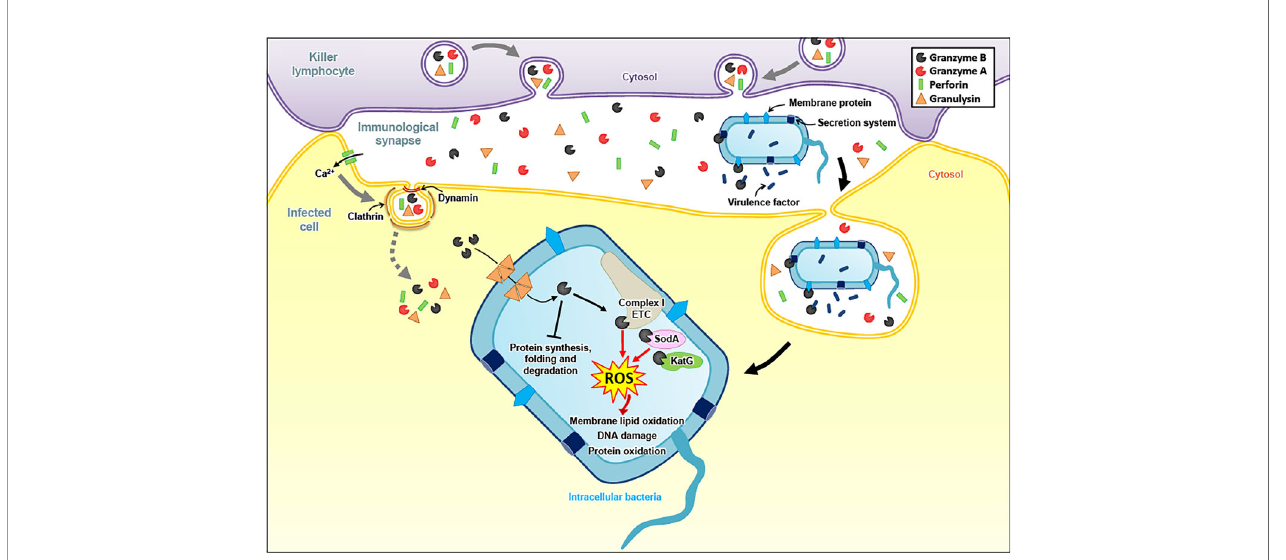
FIGURE 2 | Granzyme-mediated death pathways in bacteria. To fi ght intracellular bacteria, Gzms and GNLY are delivered into infected cells in a PFN dependent manner. GNLY then forms pores in bacterial membranes, allowing the entry of the Gzms into the bacterial cytosol. GzmB cleaves the catalytic subunits of electron transport chain (ETC) complex I, as well as bacterial proteins involved in antioxidant defense, generating ROS that induce membrane lipid oxidation, DNA damage and protein oxidation. GzmB also target various bacterial proteins involved in protein synthesis, folding and degradation. Independently of GNLY, extracellular GzmB directly targets external bacterial components, such as secretion systems, membrane proteins and secreted virulence factors to attenuate virulence and, consequently, to facilitate bacterial elimination in bystander cells.